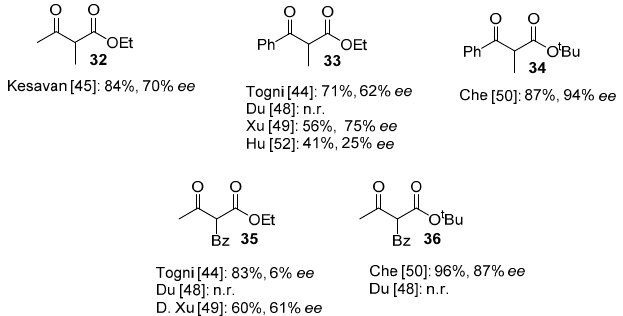
Figure 4. Fluorinated acyclic β -keto esters prepared by Togni’s research group [44].